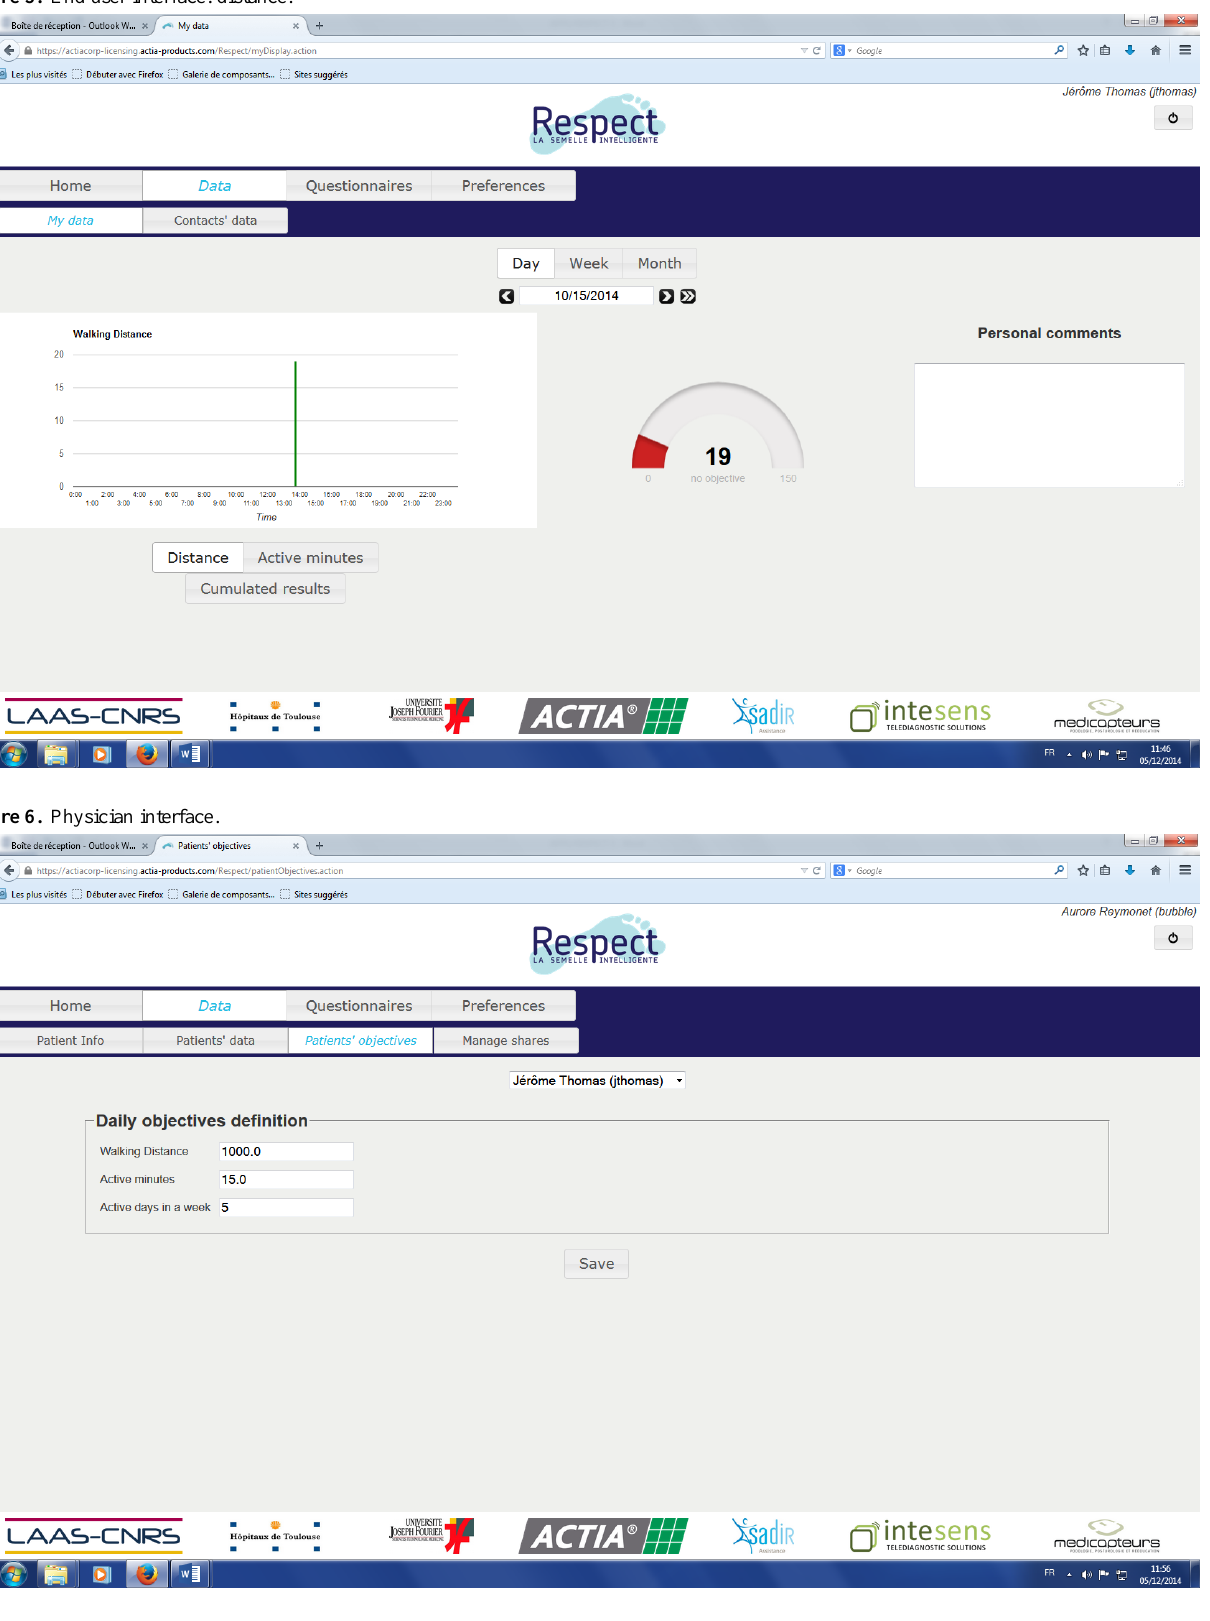
Figure 5. End user interface: distance.